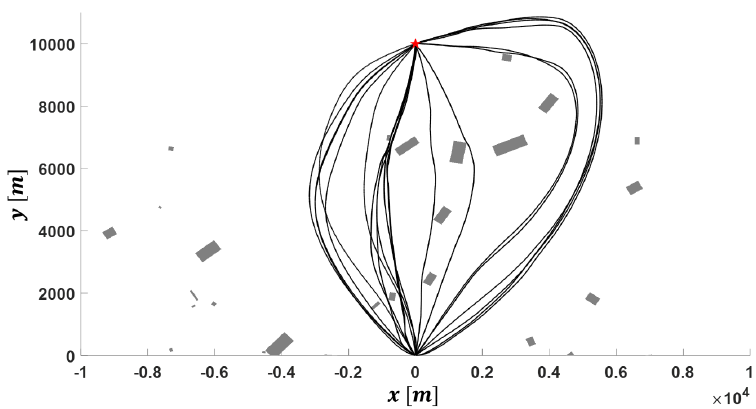
Figure 10. Multiple trajectories of scenario A.